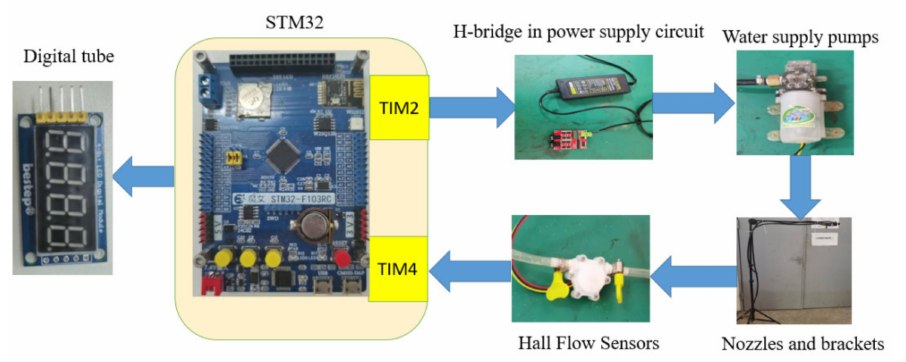
Figure 20. System Block